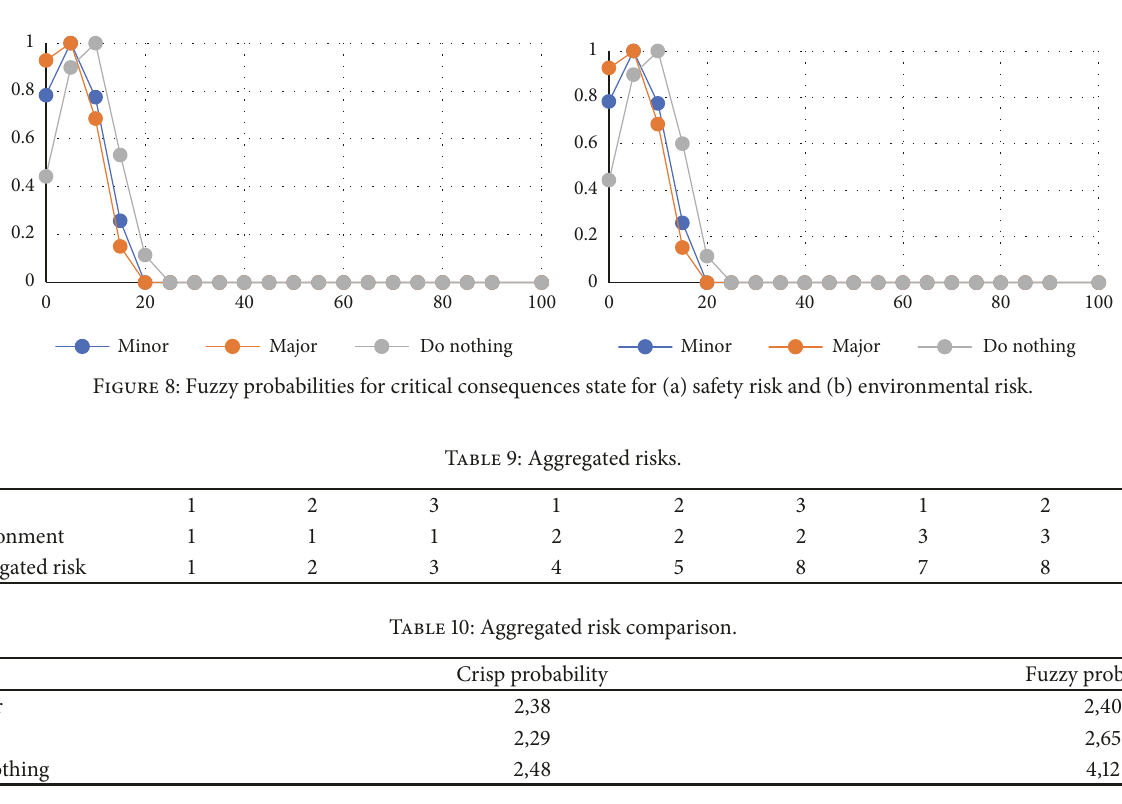
Figure 7: Fuzzy probabilities for minor consequences state for (a) safety risk and (b) environmental risk.